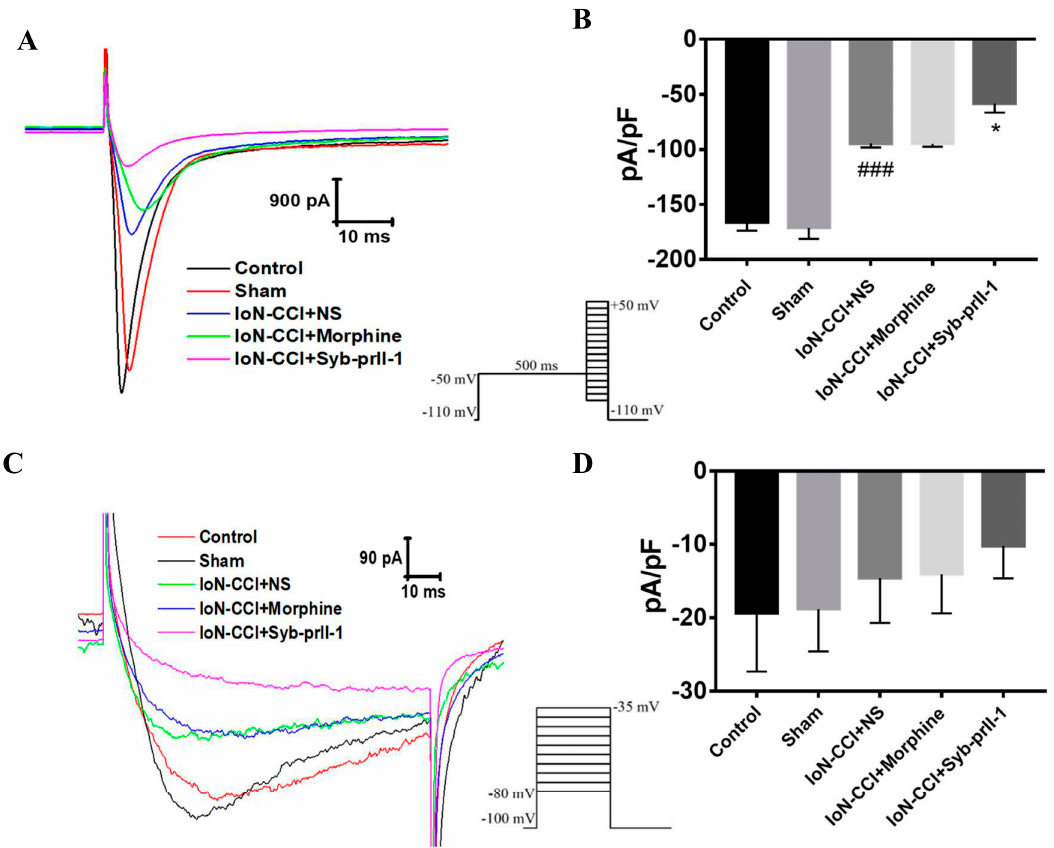
Figure 5. Changes in peak currents of Nav1.8 and Nav1.9 after IoN-CCI model and Syb-prII-1 injection. ( A ) The Nav1.8 current was evoked by a depolarizing voltage step from − 50 mV to +50 mV in 10 mV increments from a holding potential of − 100 mV ( n = 9). ( B ) Effect of Syb-prII-1 on Nav1.8 current density in TG neurons ( n = 9). ( C ) The Nav1.9 current was evoked by a single voltage step at − 35 mV from a holding potential of − 100 mV ( n = 9). ( D ) Effect of Syb-prII-1 on Nav1.9 current density in TG neurons. Data were shown as mean ± SEM. ### p < 0.001 compared with sham group. * p < 0.05 compared with model group.